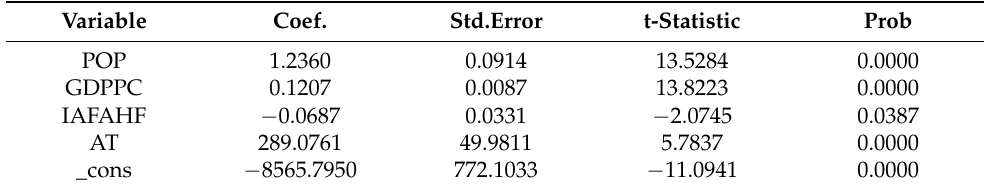
Table 7. Multiple linear regression of TNCRE.